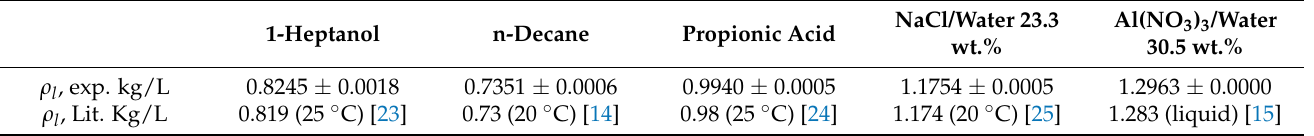
Table 2. Densities determined experimentally in the present study (at 25.9 ◦ C) and reported in literature. 1-Heptanol n-Decane Propionic Acid